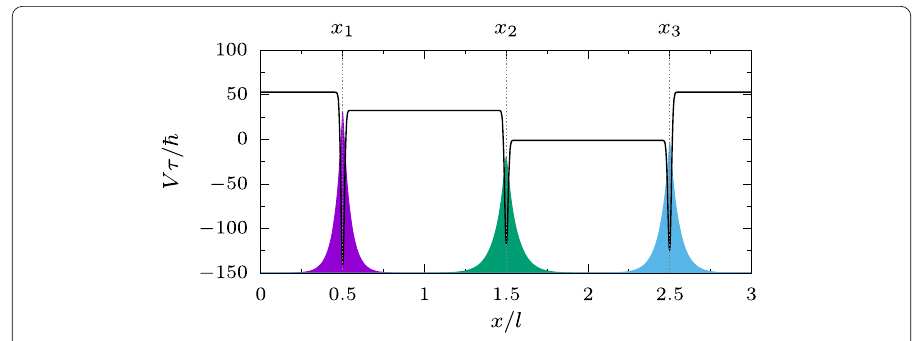
Figure 5 Schematic of the potential used in the numerical simulations (black line) with the localised states in each trap (coloured areas). The Gaussian shape of the traps is exaggerated here for